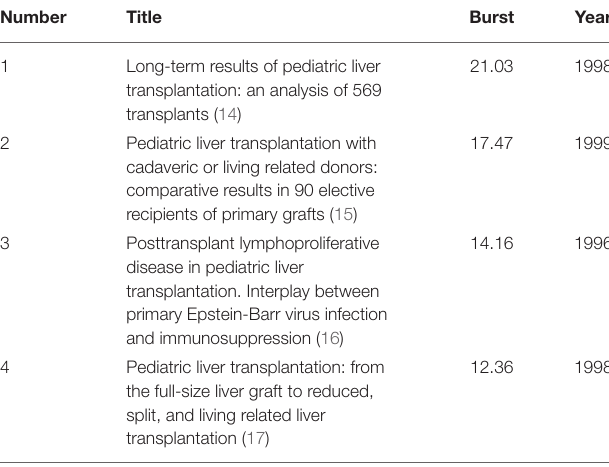
TABLE 2 | Four articles with the strongest citation bursts around